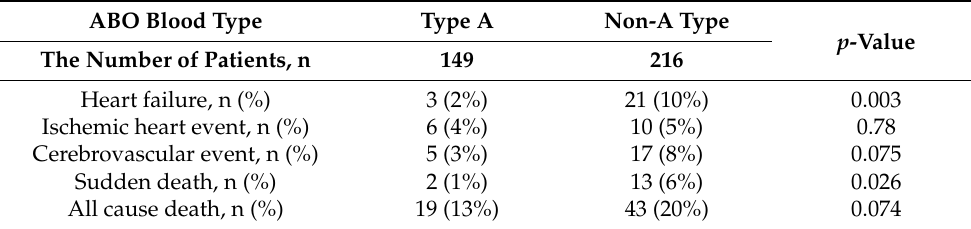
Table 4. The incidence of each clinical outcome in patients with type A and non-A